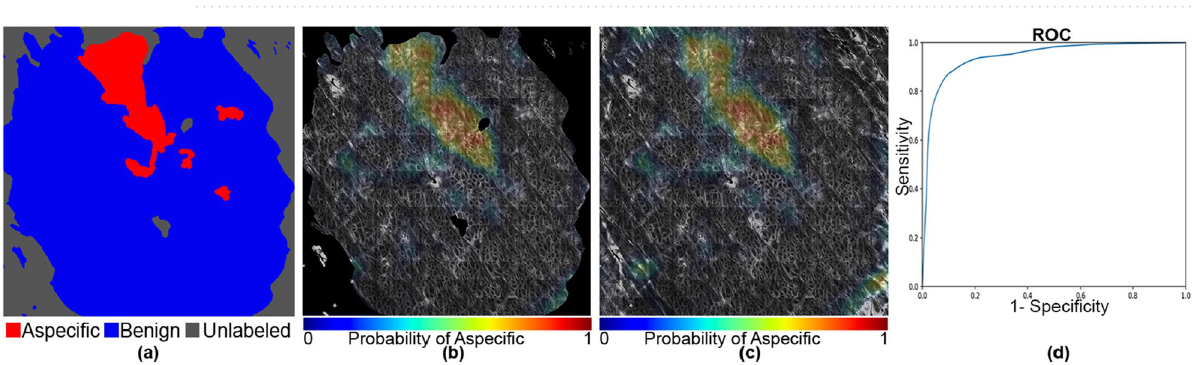
Figure 6. An example of aspecific, unlabeled, and benign patterns with an AUC of 0.942 and a Dice coefficient of 0.67. The mask and the heat map images are generated using OpenCV 4.5.1.48 (https ://pypi.org/proje ct/ openc v-pytho n/) and the ROC curve is generated using matplotlib 3.3.3 libraries (https ://matpl otlib .org/users /insta lling .html) in Python 3.7.4 (https ://www.pytho n.org/downl oads/relea se/pytho n-374/). The images and the plot, together with the legends is put together using Photoshop CC 2018 (https ://prode signt ools.com/adobe -cc-2018-direc t-downl oad-links .html).